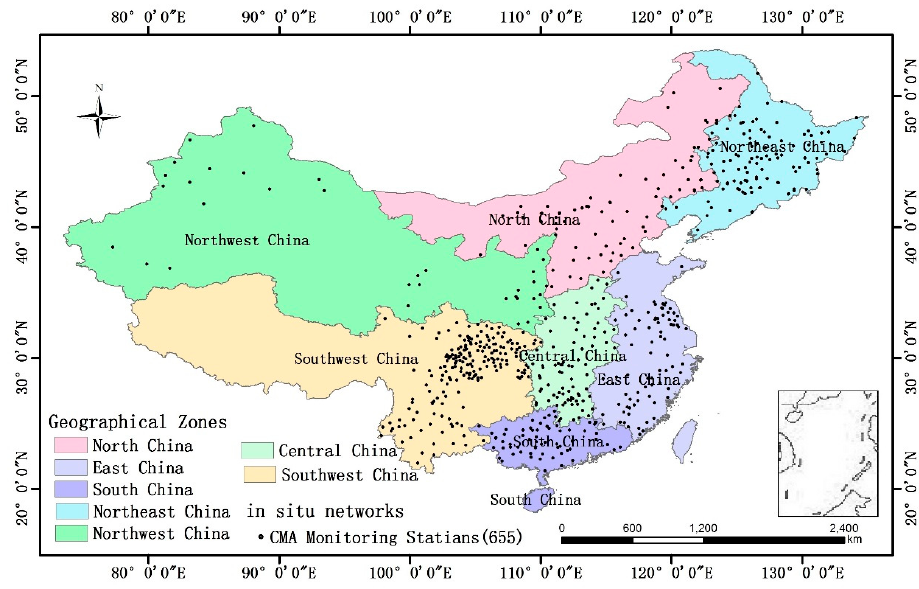
Figure 1. The spatial distribution of the seven geographical zones and 655 CMA monitoring stations across continental China.